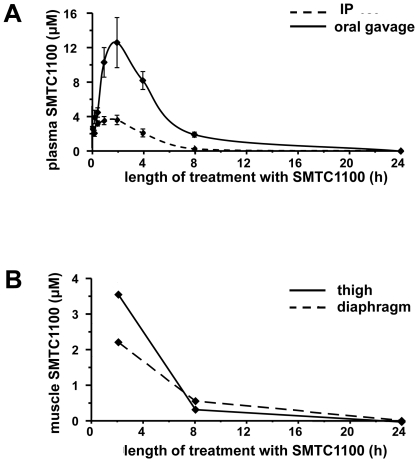
Plasma levels of SMT C1100 in the mouse.(A) SMT C1100 plasma levels were assessed over a 24 h period after oral
gavage or i.p. delivery of 50 mg/kg of the compound into wild type CD1
mice. At set time points after administration groups of three animals
were taken for blood samples at the times stated in the figure. (B)
Thigh and diaphragm samples from CD1 dosed orally with 50 mg/kg were
quantified for the presence of SMT C1100.